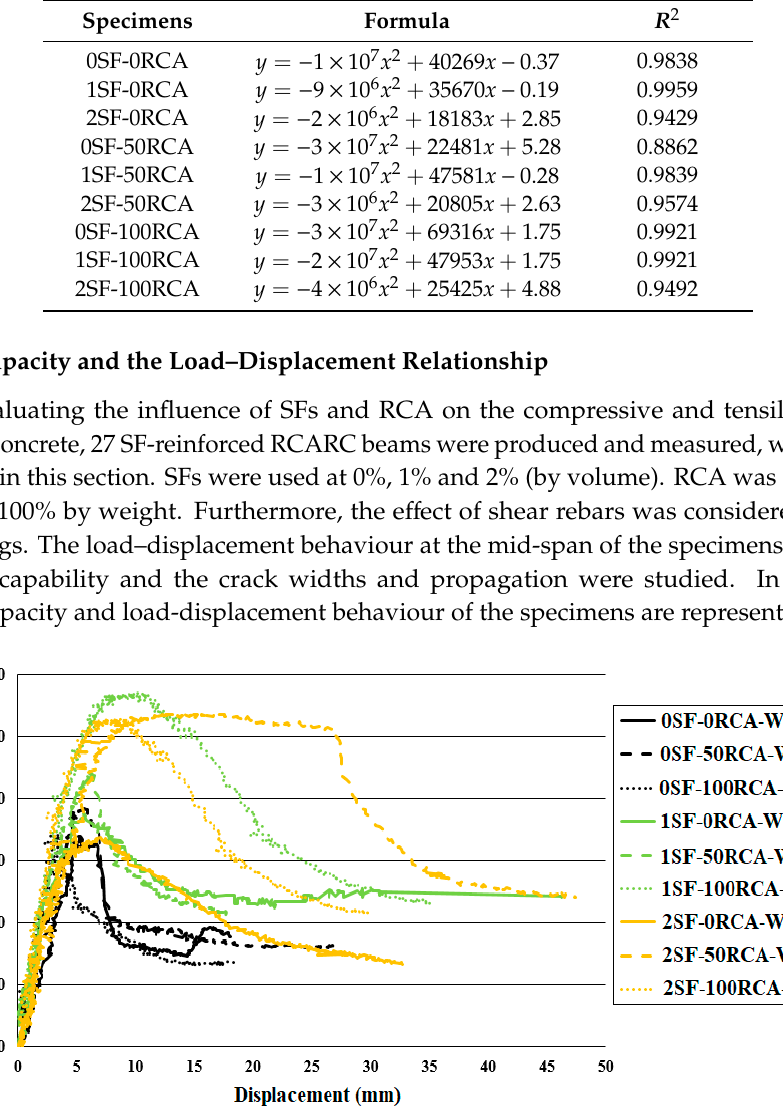
Figure 14. Bending behaviour of the specimens with various SF and RCA contents and no shear rebars. WTD: without transverse reinforcement